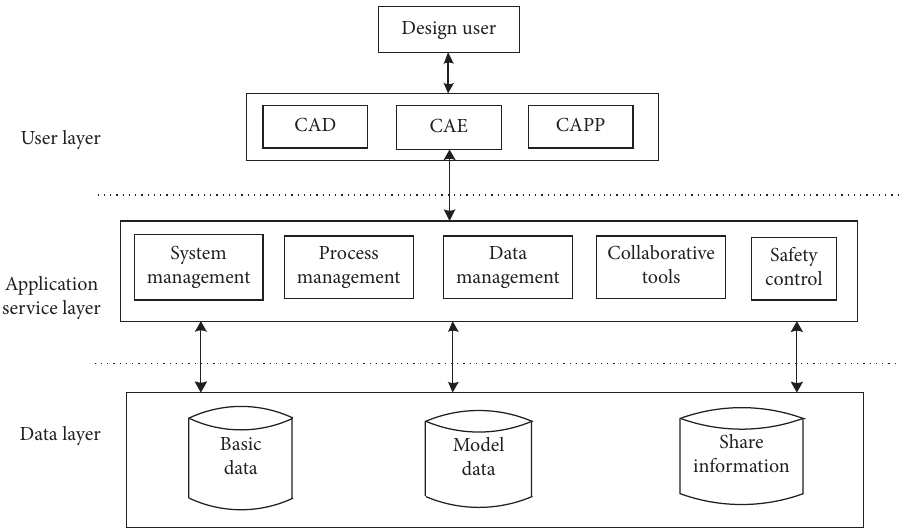
Figure 3: Structure of the collaborative product synchronous design pattern. Table 1: Experimental environment